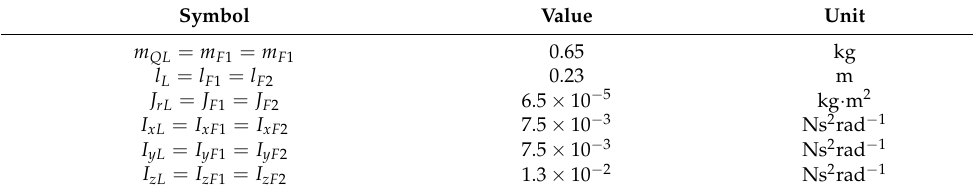
Figure 3. Applied acceleration type disturbance in X and Y dynamics. Table 1. Leader-followers UAV parameters.